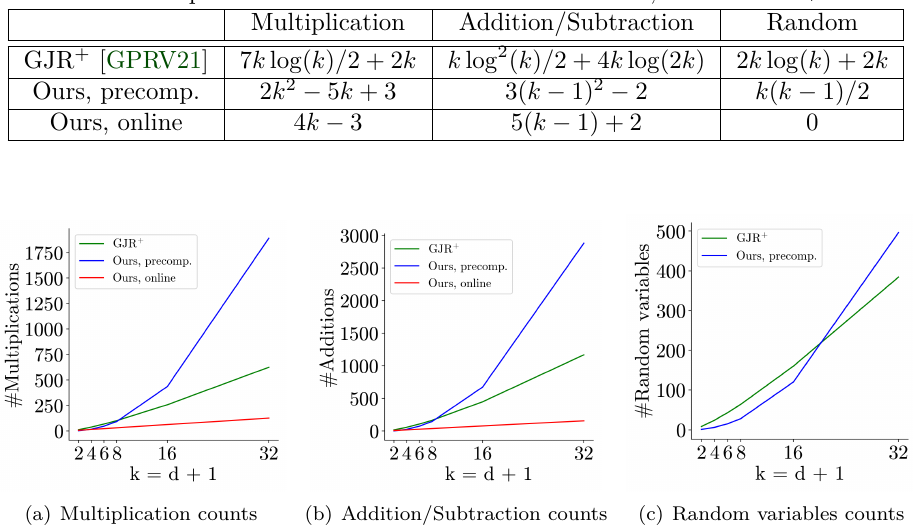
Table 3: Operation counts for GJR + and our scheme, where k = d + 1.